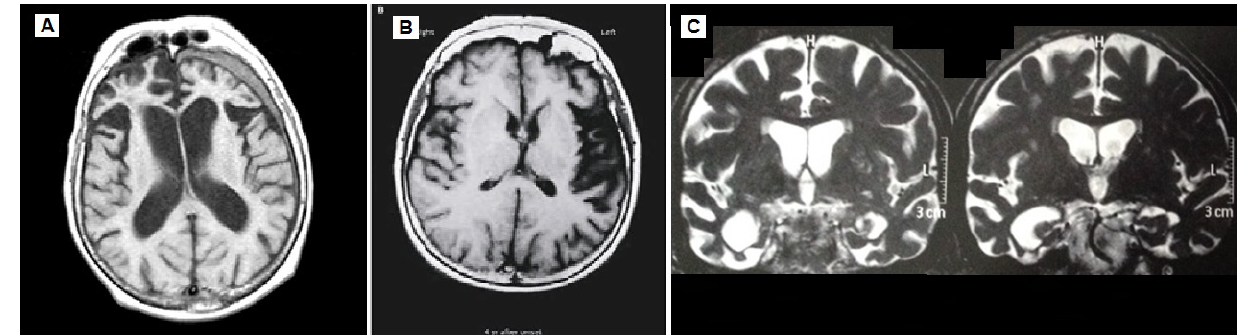
Figura 3. A . Atrofia focal de regiões frontotemporais na variante comportamental da Demência Frontotemporal; B . Atrofia do giro frontal inferior do hemisfério dominante na afasia progressiva primária não-fluente/agramática (APP-NF/A); C . Atrofia focal de pólo temporal na afasia progressiva primária semântica